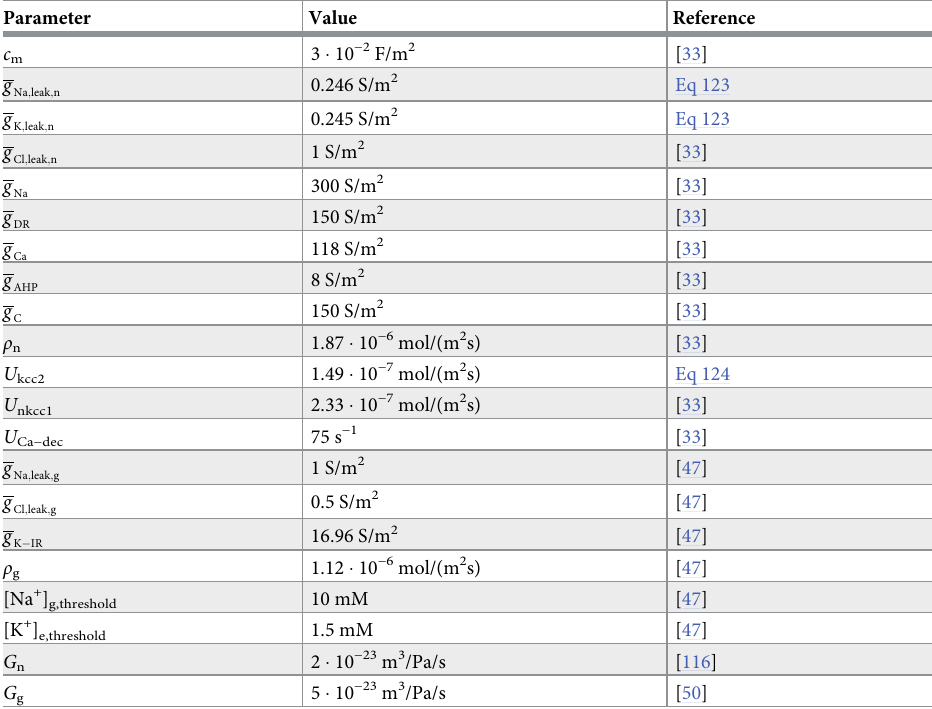
Table 4. Membrane parameters.